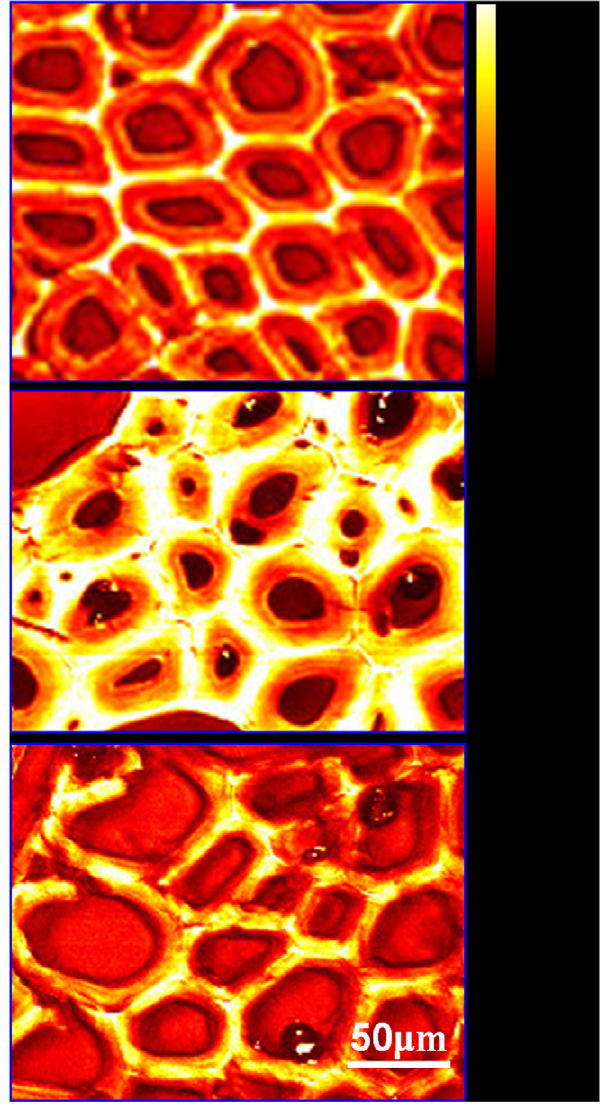
Figure 3. Coherent Raman scattering (CRS) micrographs of poplar cell walls. The lignin signal (1600 cm 2 1 ) was obtained using coherent anti-Stokes Raman (CARS) microscopy. In the untreated cell walls (a), lignin is unevenly distributed across cell walls, compound middle lamella have most lignin content; when treated in anaerobic condition (b), polysaccharides are consumed by anaerobic microbes, relative lignin signal is increased; and when treated in aerobic condition (c), aerobic microbes consume polysaccharides (cell walls become thinner), and degrade/modify lignin simultaneously, lignin signal retain unchanged compared with untreated cell walls.